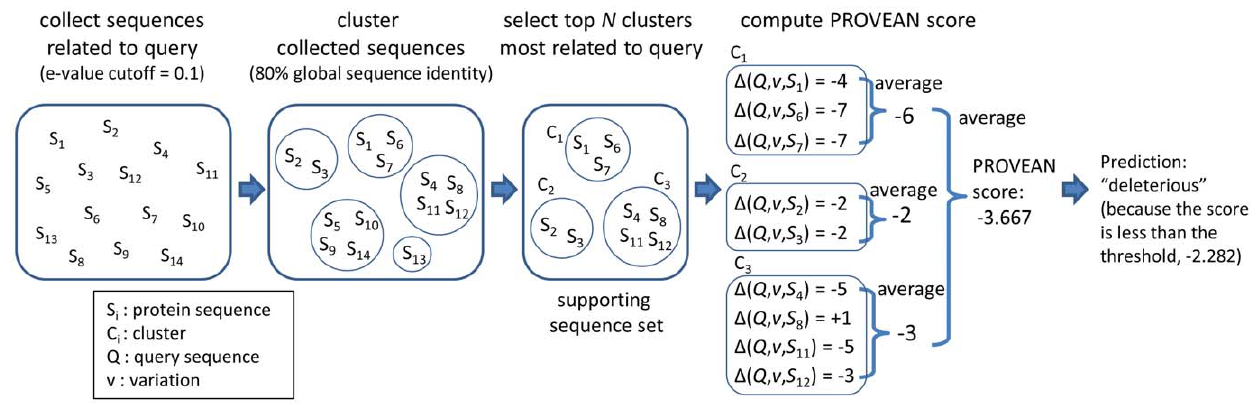
Figure 10. Computing the PROVEAN score. For simplicity, only the top three clusters were included in building the supporting sequence set in this example.